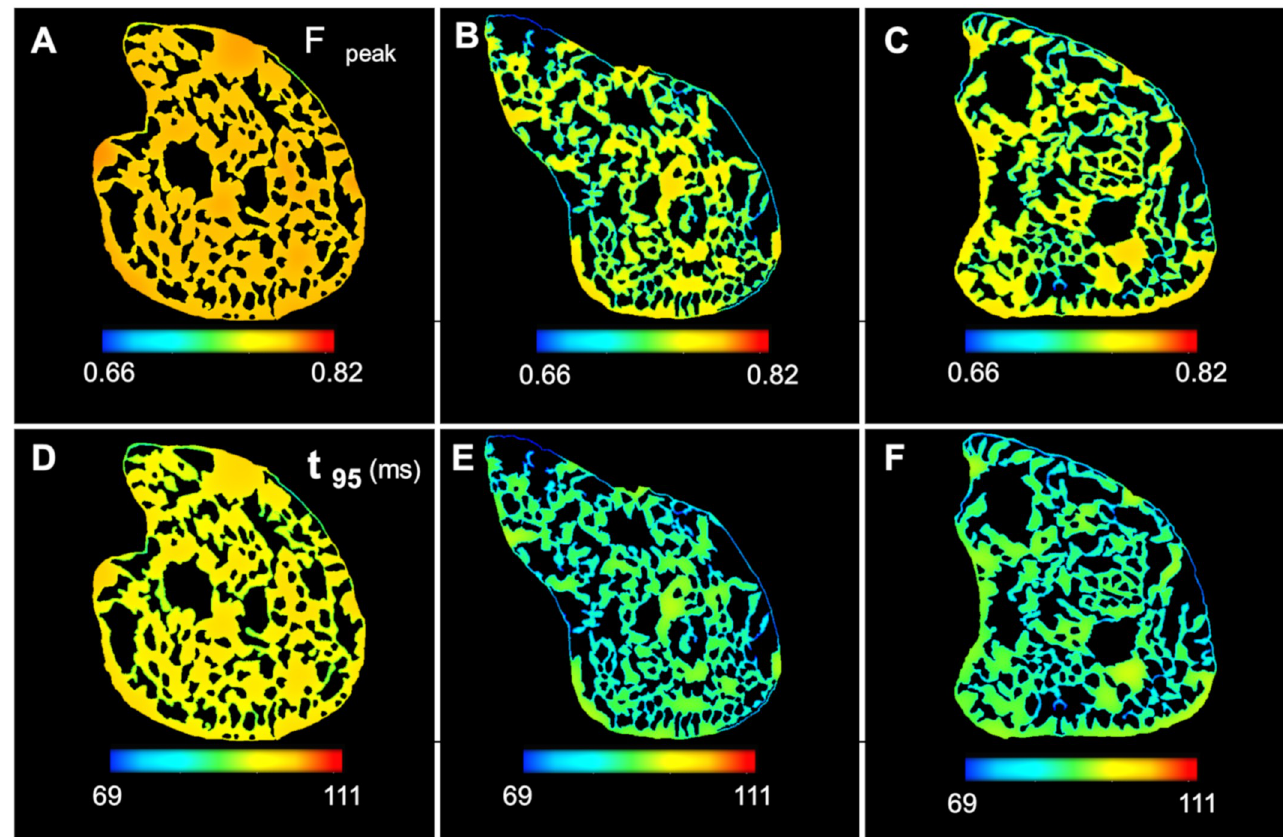
Fig 7. Force dynamics of the cell corresponding to the model predicted phosphagens distribution. (A-C): F peak is uniform across section 1 and exhibits slight spatial variation in section 2 and 3. (D-F): t 95 shows similar spatial gradients across the cross sections.